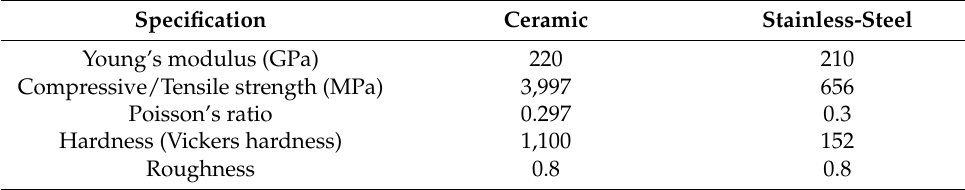
Table 2. Material properties.